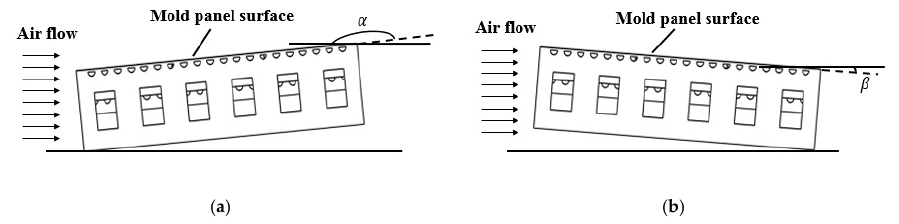
Figure 13. Two types of tilt methods. ( a ) Type 1, ( b ) Type 2.